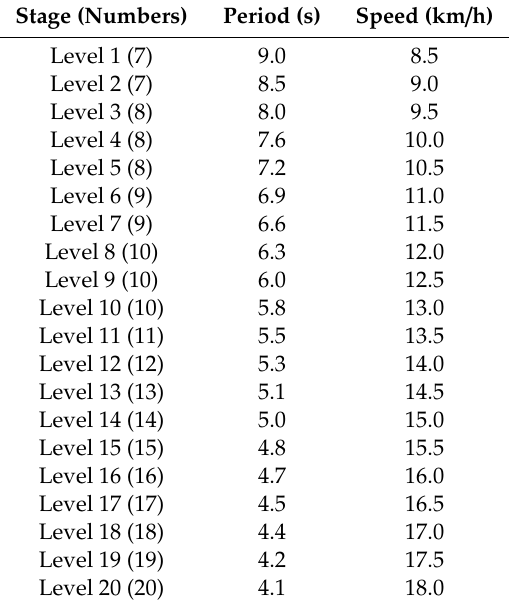
Figure 2. Fatigue inducement test (20 m shuttle run). Table 3. Sectional acceleration of shuttle run